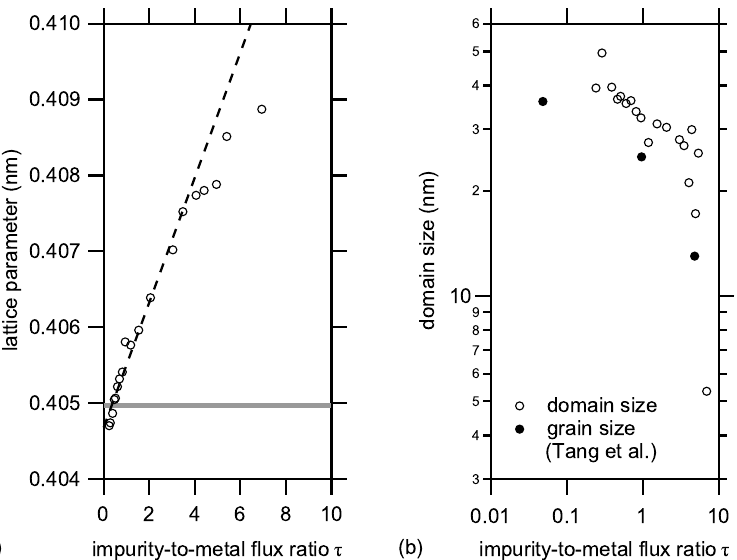
Figure 3. Lattice parameter ( a ) and domain size ( b ) of the aluminum thin films embedded in the multilayer as a function of the impurity-to-metal flux ratio τ . The lattice parameter was determined based on the position of the (111) Bragg reflection. The domain size was calculated from the FWHM of the same peak. The full markers refer to the grain size determined by TEM for aluminum layers deposited at different base pressures as published by Tang and co-workers